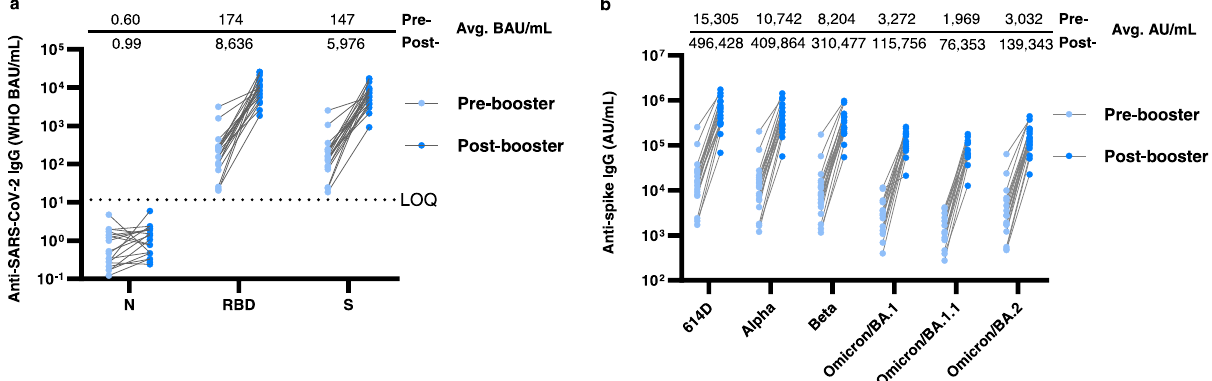
Fig. 4 Evaluation of anti-SARS-CoV-2 IgG binding activity in mRNA vaccinee sera (pre- and post-booster). Each dot represents calculated IgG concentration (BAU/mL or AU/mL) of an individual serum sample against a speci fi c protein antigen. The geometric mean IgG concentrations (avg. BAU/ mL or AU/mL) from pre- and post-booster sera are shown on the top of the graph. For statistical analysis, a two-tailed Wilcoxon matched-pairs signed- rank test was performed by comparing antibody concentration of pre- and post-booster sera. Test statistics and P value are summarized in Supplementary Table 2. Source data are provided as a Source Data fi le. a IgG antibodies speci fi c to SARS-CoV-2 nucleocapsid (N), receptor binding domain (RBD) and spike(S) were measured. N = 18 – 20 biologically independent pre-booster sera (light blue) and N = 18 – 20 biologically independent post-booster sera (dark blue). The average IgG concentrations in all post-booster sera differ signi fi cantly ( P < 0.0001) from the pre-booster sera, except those speci fi c to the nucleocapsid ( P = 0.1084). Dashed line represents the limit of quanti fi cation for the N protein. LOQ = 11.8. b IgG antibodies speci fi c to SARS-CoV-2 spike proteins of 6 different viruses were measured. N = 17 – 20 biologically independent pre-booster sera (light blue) and N = 17 – 20 biologically independent post-booster sera (dark blue). The average IgG concentrations in all post-booster sera differ signi fi cantly ( P < 0.0001) from the pre-booster sera. BAU: binding antibody units calibrated to WHO international standard. AU arbitrary